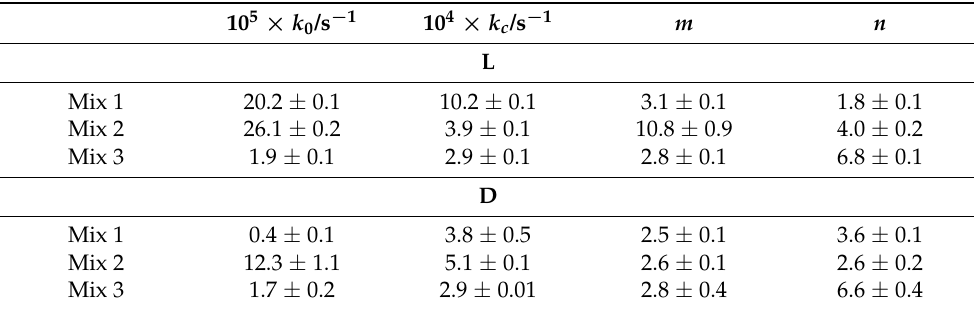
Table 2. Relevant kinetic parameters for the J-aggregation of H 2 TPPS 44 − ( k 0 , k c , m , and n ) as functions of different mixing order protocols.